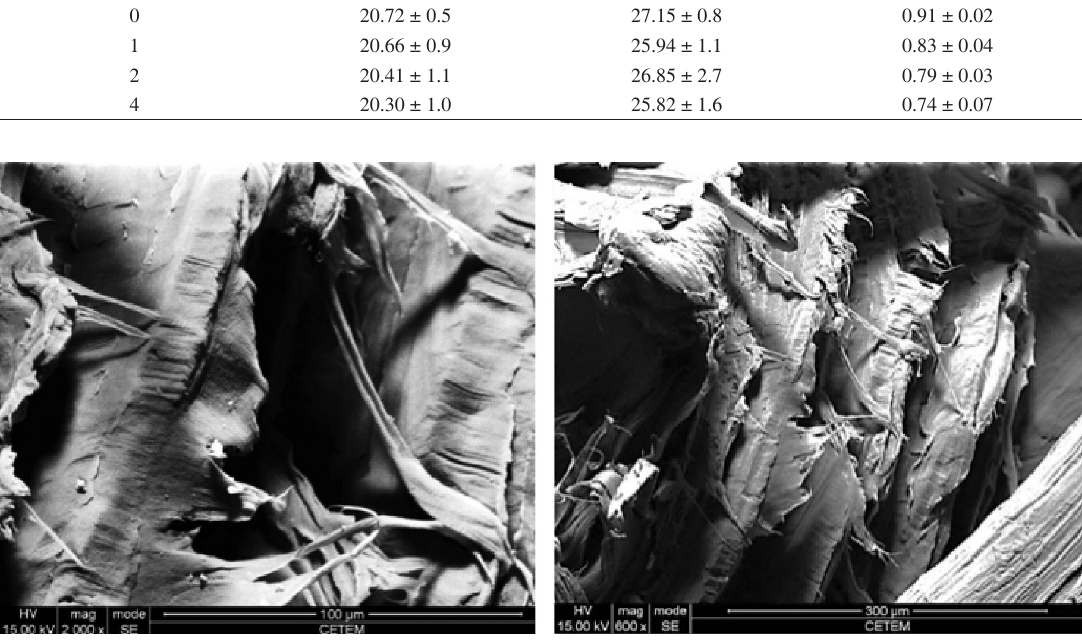
Figure 7. SEM images of the composites containing 4% of sisal